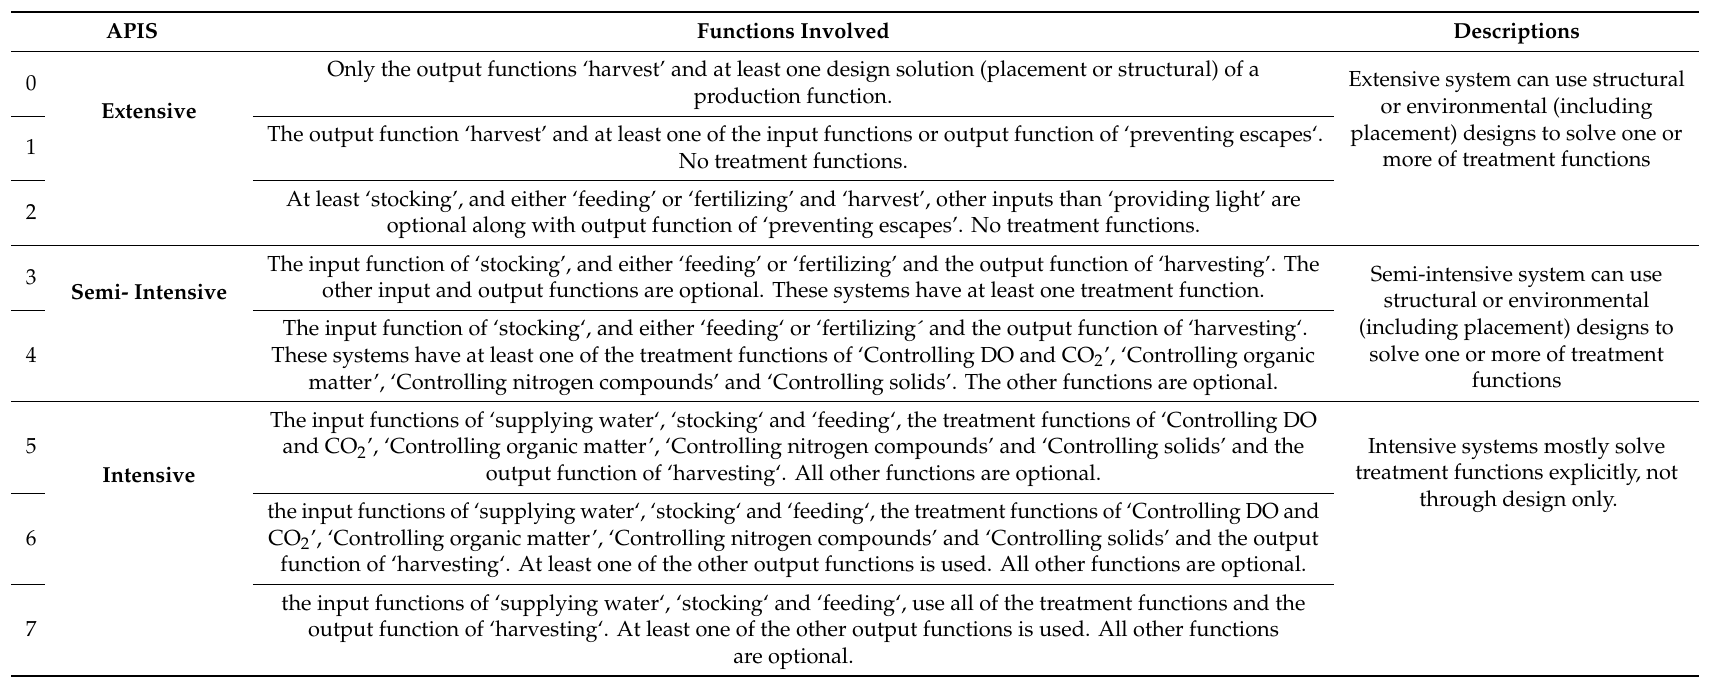
Table 1. Aquaculture Production Intensity Scale (APIS) and its levels.